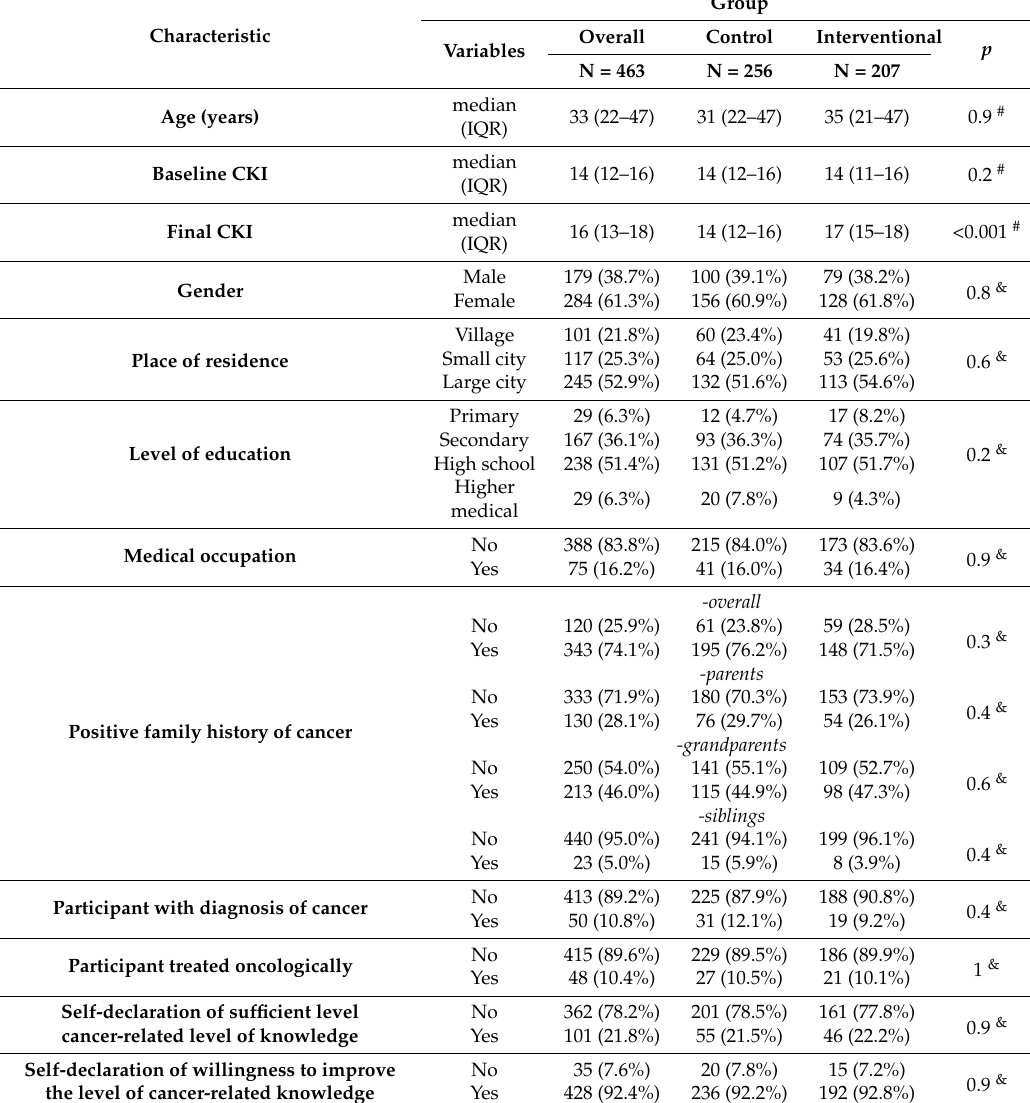
Table 1. Characteristics of subjects in the interventional and control